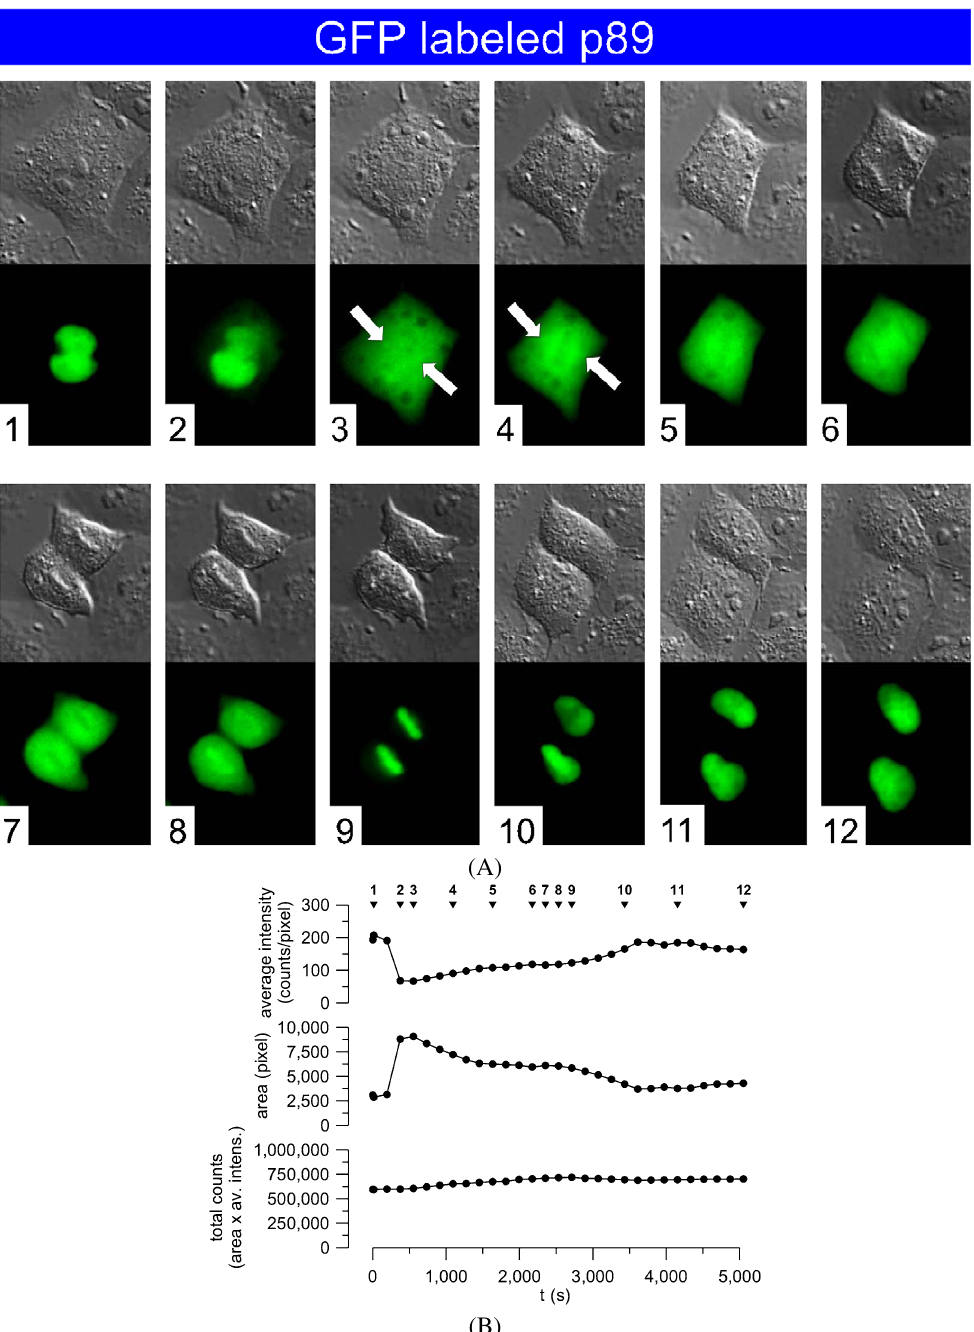
Fig. 4. Kinetics of p89 during the cell cycle. (A) Live imaging of GFP-p89 with time lapse series. During interphase, p89 is nearly exclusively in the nucleus. Upon prometaphase (1–2), at the same time the nuclear membrane breaks off, p89 detaches from the chromosomes to localize to the centrosomes (3). In late telophase, there is a sudden re-association of p89 with the chromatin (compare panels 7 and 8), and GFP-p89 localization is again confined to the newly forming nuclei (9–12). Panels: Differential interference contrast (DIC) microscopy (top) and corresponding GFP-p89 (bottom). Time points correspond to the arrowheads depicted in (B). (B) Quantification of fusion protein reveals spatial changes in intensity upon entry into mitosis, reflecting the re-distribution parallel to fall-off from the chromatin. However, overall intensity is nearly constant (lower